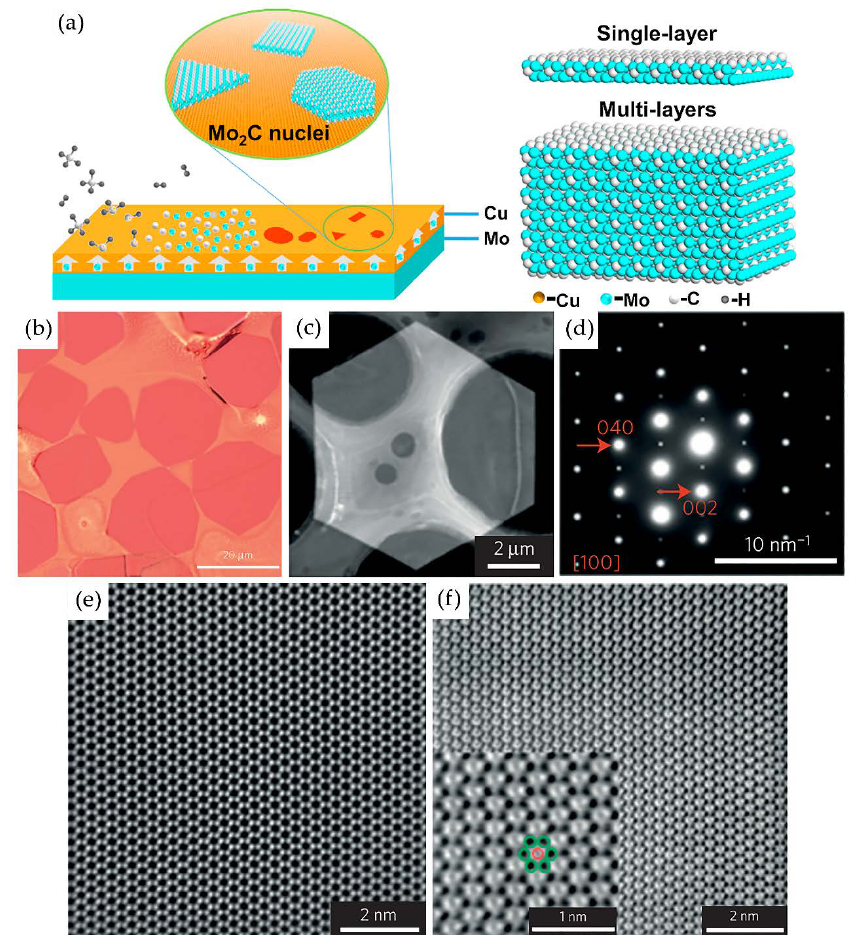
Figure 17. ( a ) Schematic representation of the synthesis of two-dimensional Mo 2 C crystals on a Cu/Mo substrate and a model of the atomic s tructure depending on their thickness. Images of ultrathin α -Mo 2 C films with different shapes (opti- cal microscope). STEM images of hexagonal α -Mo2C obtained with a high-angle annular darkfield detector with low ( b ) and high ( c ) resolution. ( d ) Electron diffraction pattern of the selected area along the [100] axis. Atomic resolution high- angle annular dark-field (HAADF)-STEM and ( f ) bright-field (BF)-STEM micrographs. Mo atoms, which are seen as white dots €( e ), are located in a hexagonal close-packed structure, while C atoms are centered between six Mo atoms. Green circles in ( f ) indicate Mo atoms, and the red circle is assigned to C. Reprinted with permission from [77,78] 2019 Springer Nature and 2015 Springer Nature.